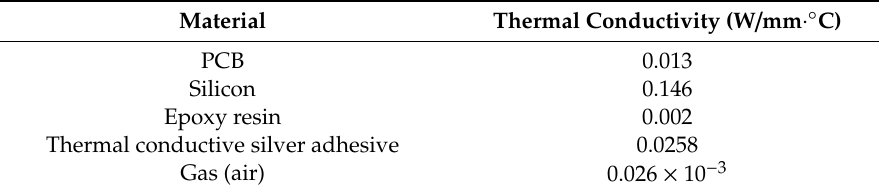
Table 2. SiP materials and corresponding thermal conductivity [14].